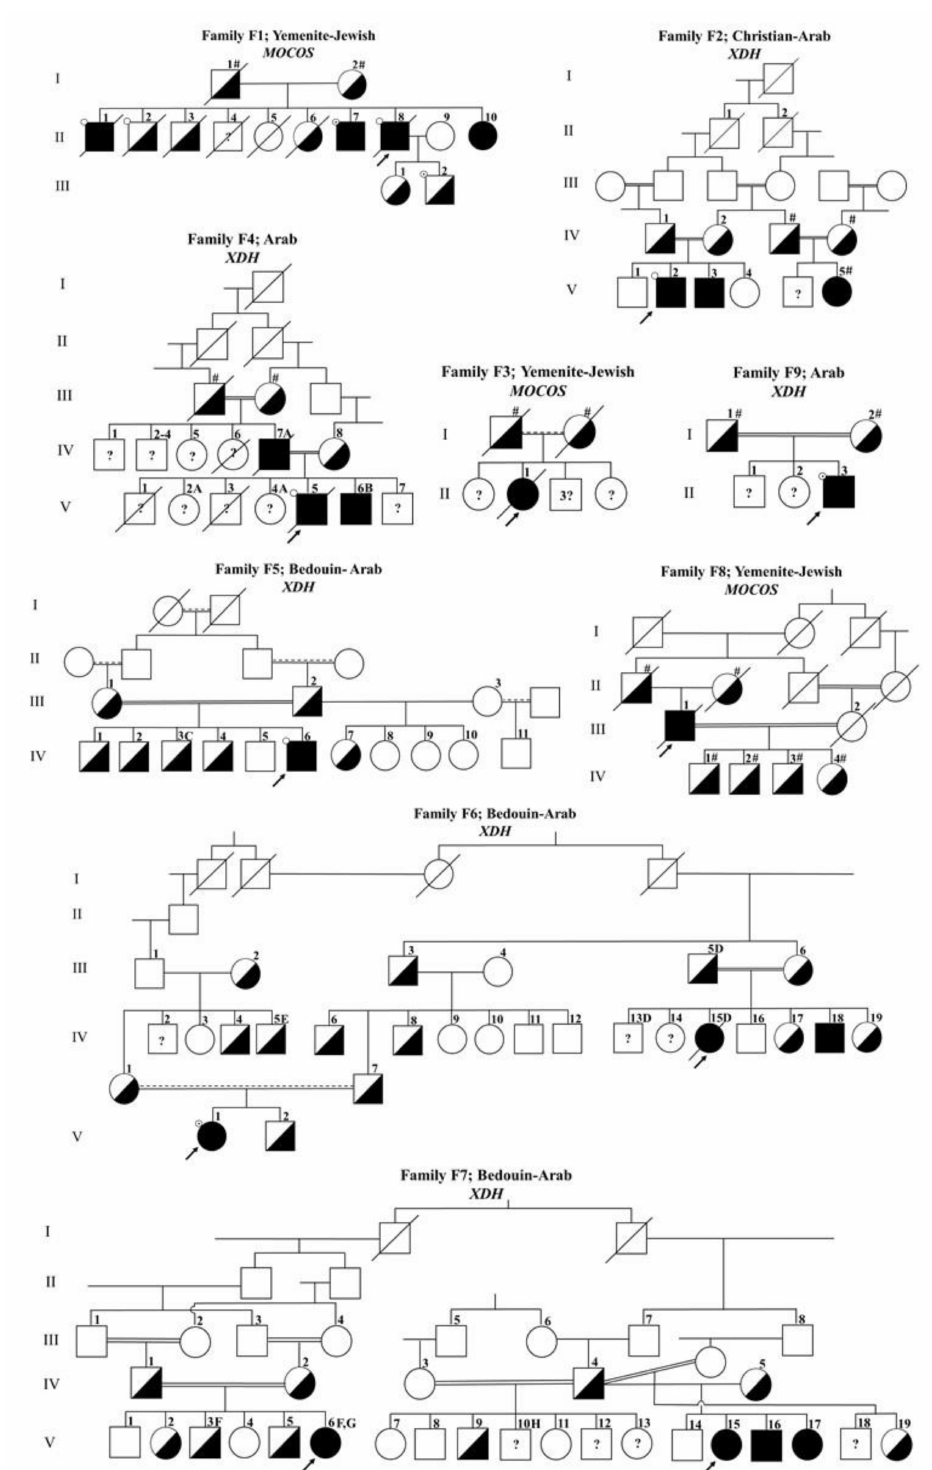
Figure 1. Pedigrees of nine Israeli families affected by classical xanthinuria. Symbols: filled circle/rectangle—affected female/male, half-filled circle/rectangle—obligatory/identified carrier of disease-causing variant, arrows point to the index case, ?—no samples available for analysis, #—not genotyped obligatory carrier/affected and a small circle without or with a dot on the upper-left side of the symbol represents a kidney stone or suspected urolithiasis, respectively. Congenital disorders observed in family members: A—prolidase deficiency, B—severe global developmental delay, C—small dysplastic kidney with reduced function, D—congenital glaucoma, E—spherocytosis, F—Bartter-like tubulopathy, G—Osteogenesis imperfecta and H—spina